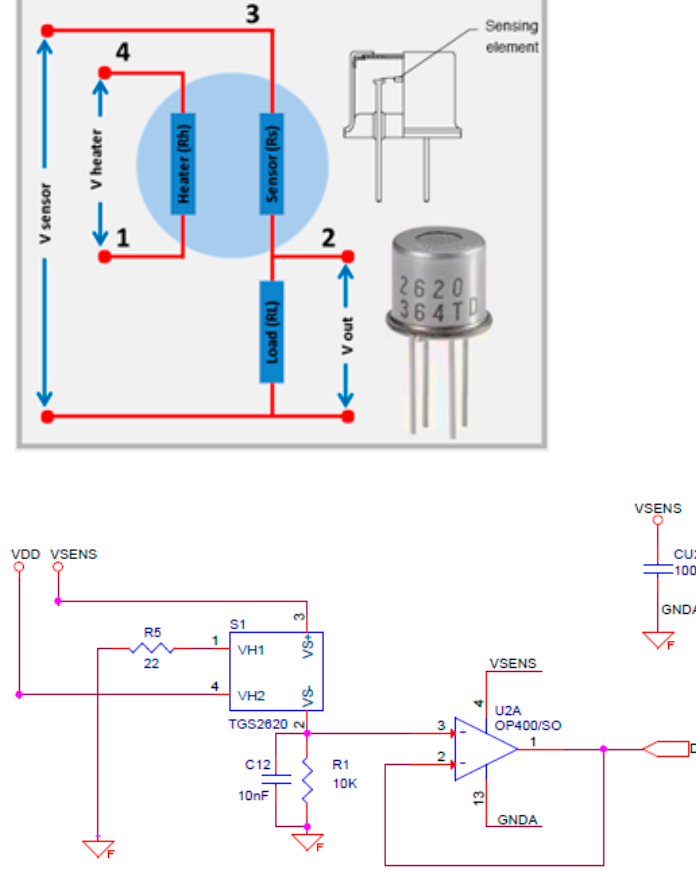
Figure 2. Circuit diagram for TGS2620. Table 2. TGS2620 specifications [20].